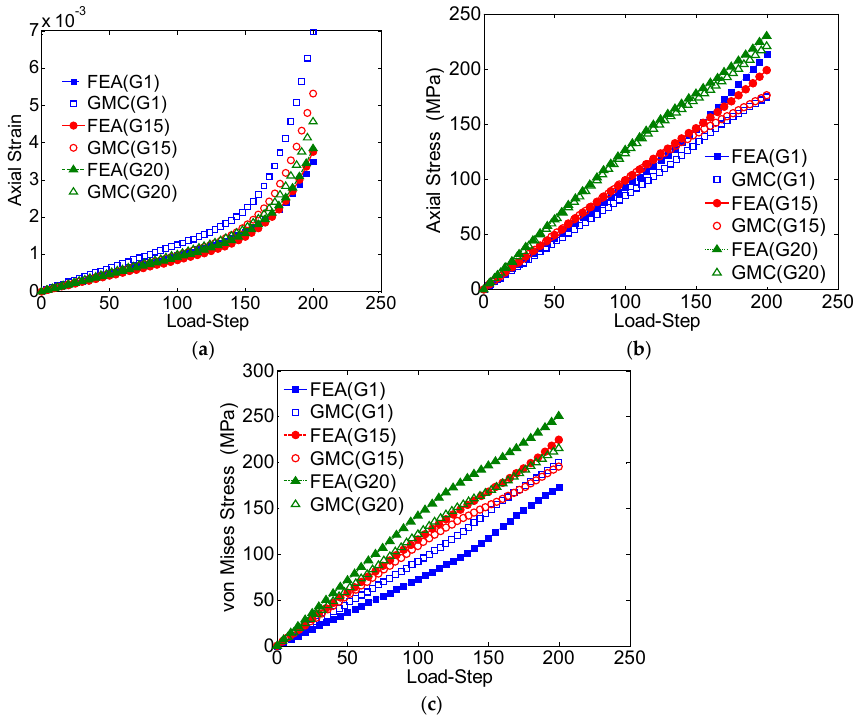
Figure 9. ( a ) Average axial strain ( ε zz ) vs . load-step; ( b ) average axial stress ( σ zz ) vs . load-step; ( c ) von Mises stress vs . load-step, for three randomly selected grains.